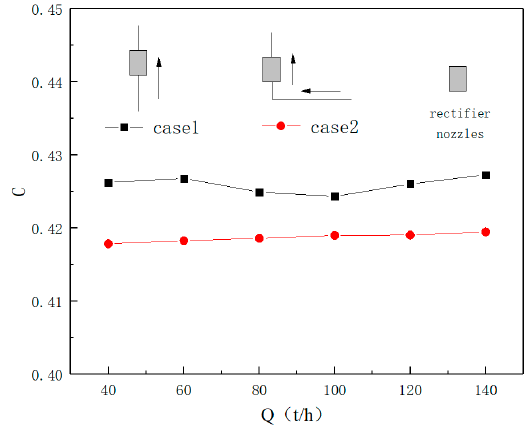
Figure 8. Discharge coefficients of rectifier nozzles.